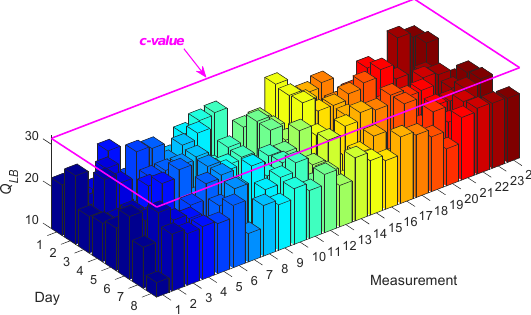
Figure 3. Ljung–Box Q-test (LBQ) test statistics for ARMA(33,33) to model the vibration responses at Sensor 8 for all test measurements on Days 1–8.